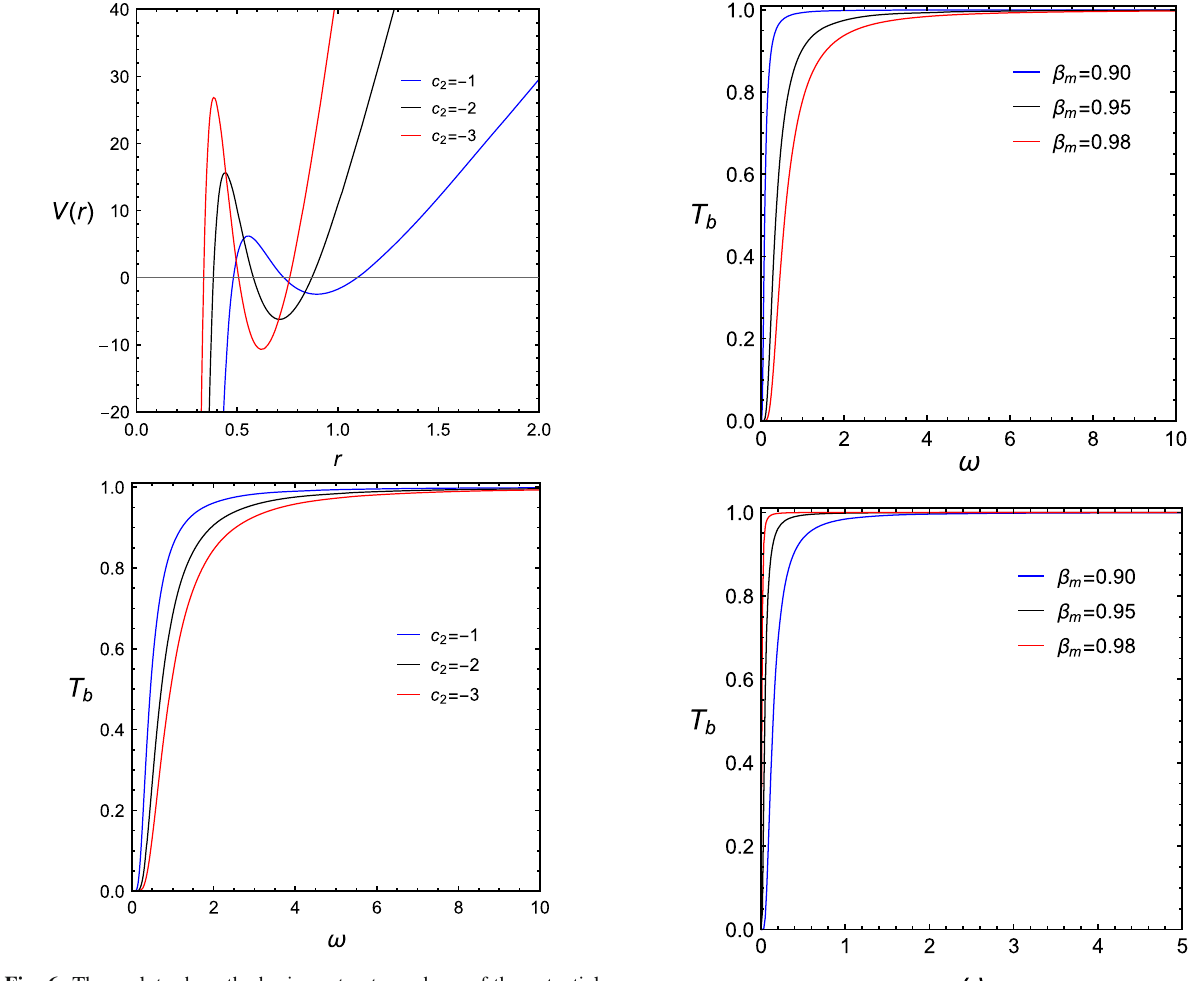
Fig. 6 These plots show the horizon structure, shape of the potential and the greybody factor bound for different values of c 2 , with M = 1 and β m = 1 . 1 Fig. 7 Plot of T b using different values of β m , with (cid:16) = 0 , M = 1 and